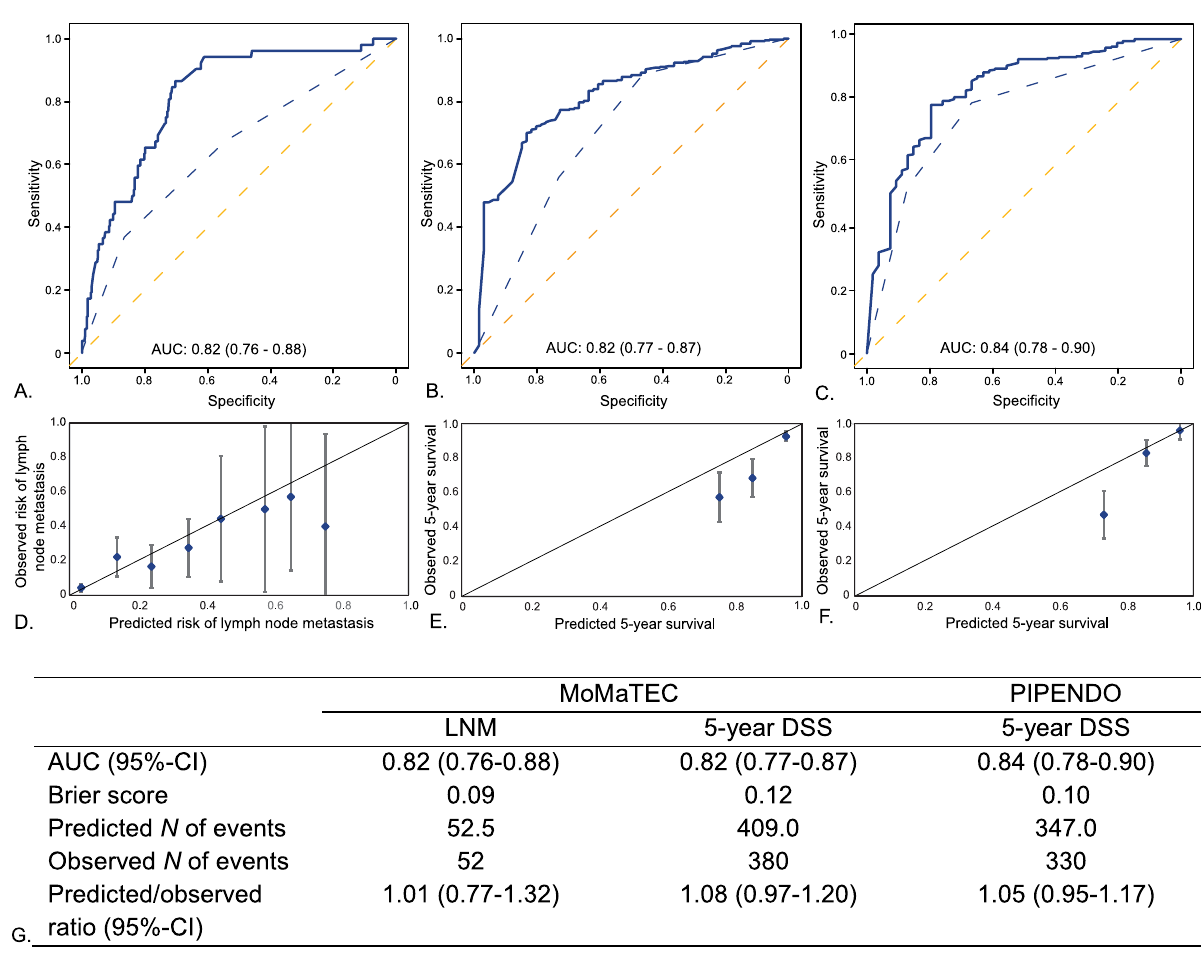
Fig 4. ROC curves. (A) Prediction of LNM in the MoMaTEC cohort, (B) prediction of 5-year DSS in the MoMaTEC cohort, and (C) prediction of 5-year DSS in the PIPENDO cohort. Calibration plots for (D) prediction of LNM in the MoMaTEC cohort, (E) prediction of 5-year DSS in the MoMaTEC cohort, and (F) prediction of 5-year DSS in the PIPENDO cohort. (G) Concordance statistics of the BN. The solid blue lines represent the ROC curves obtained by ENDORISK. The blue dotted lines represent the ROC curves including obtained by using only preoperative tumor grade as predictor (as a reference). The vertical bars in panel D represent 95% CIs. AUC, area under the curve; BN, Bayesian network; CI, confidence interval; DSS, disease-specific survival; ENDORISK, preoperative risk stratification in endometrial cancer; LNM, lymph node metastasis; MoMaTEC, Markers for the Treatment of Endometrial Cancer; PIPENDO, PIpelle Prospective ENDOmetrial carcinoma; ROC, receiver operating characteristic.